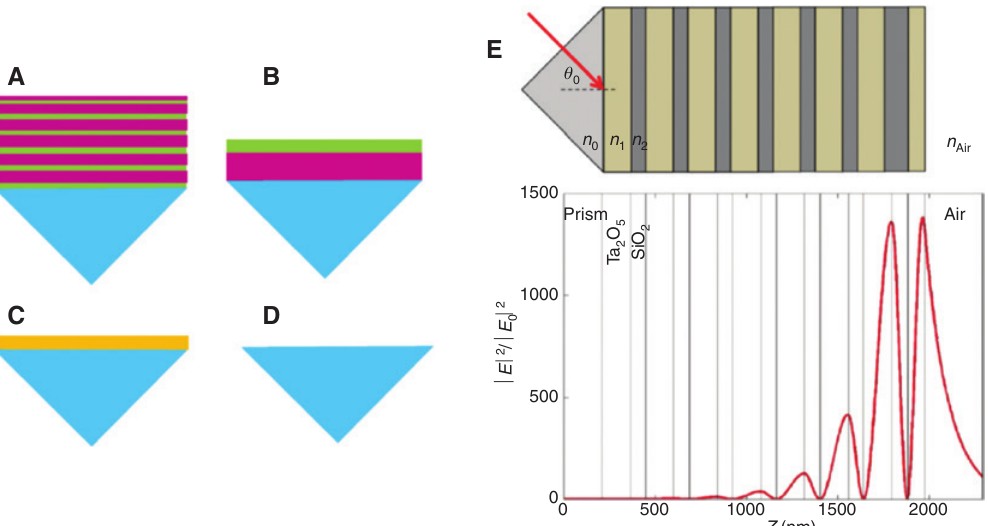
Figure 4: Structure for generating BSWs in comparison with other structures for enhanced spectroscopy. (A) multilayer structure with BSWs, (B) WG structure, (C) metallic structure with SP modes, and (D) bare prism of the reference. Reprinted with permission from [22]. © The Optical Society. (E) Sample design optimized for a laser line of λ = 633 nm, TE polarized and incident with an angle θ of 45 ° . The resulting sample is a 15-layer stack of alternated low (SiO 0 throughout the stack with field enhancement above 1000 at the interface with air. Reprinted from [23] with permission from AIP Publishing.